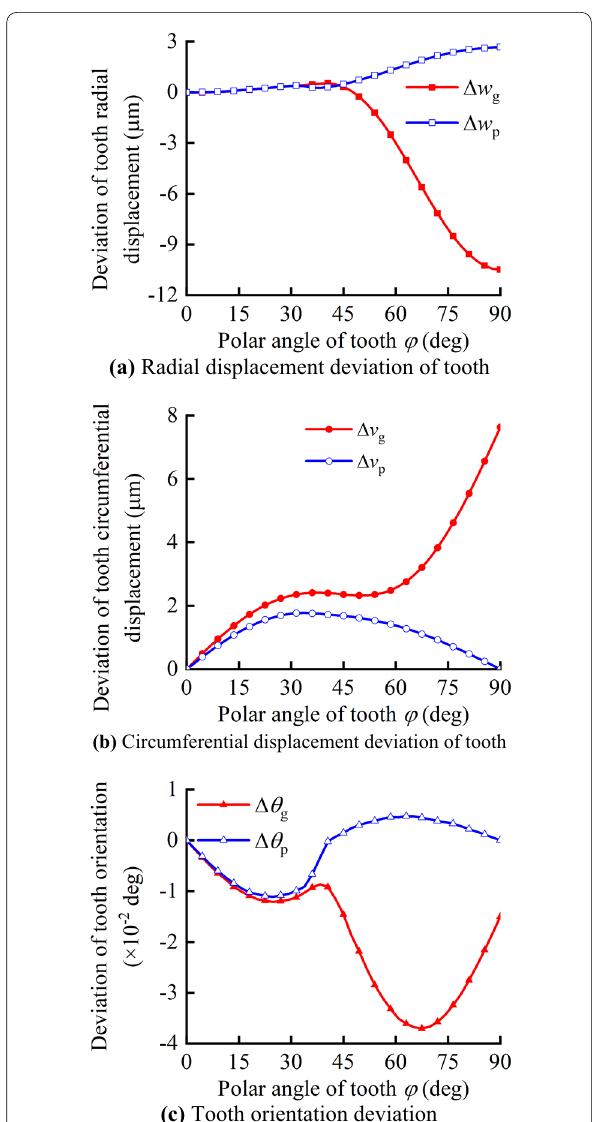
Figure 18 Positioning deviation of tooth on